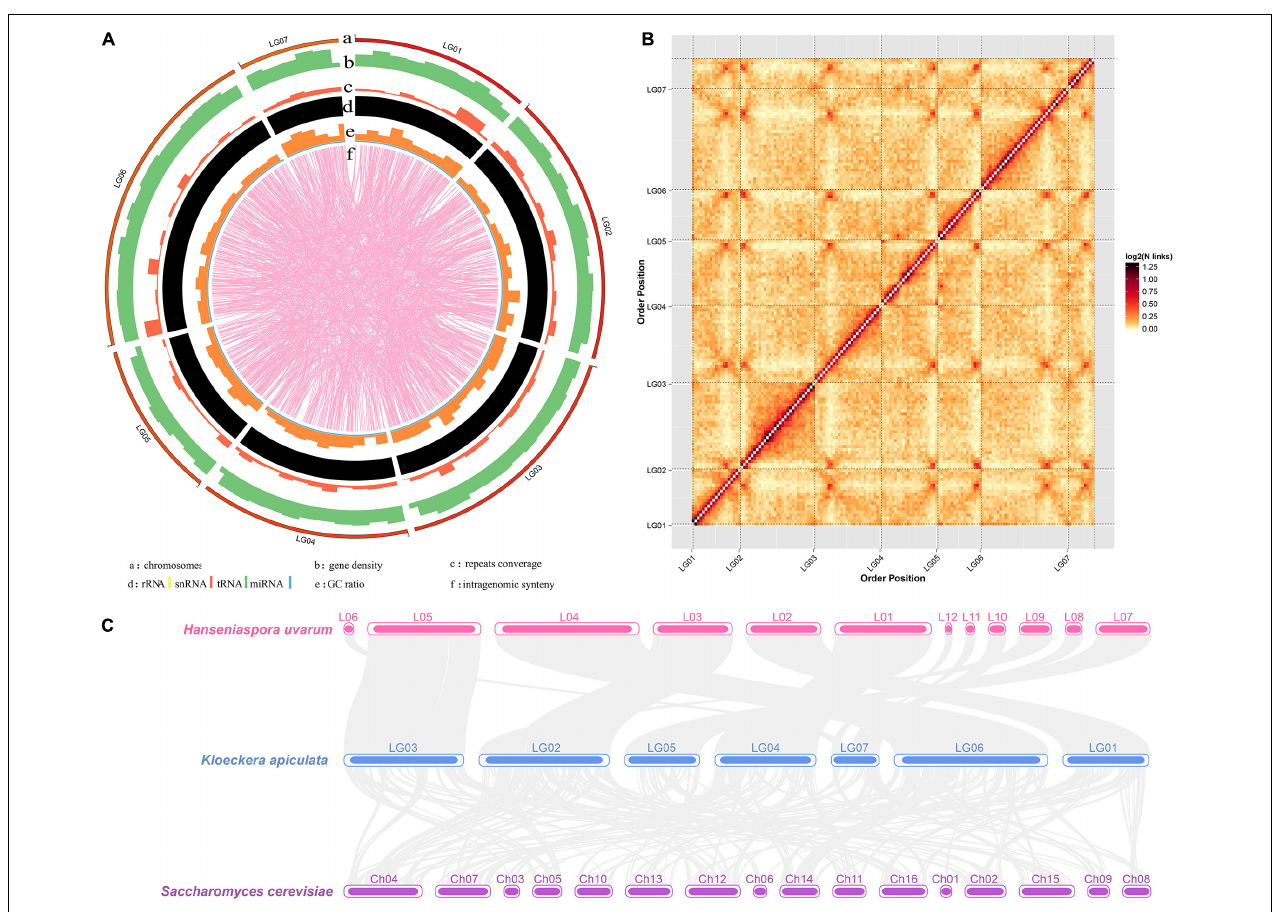
FIGURE 1 | Chromosome resolution genome of K. apiculata . Genome synteny of Hanseniaspora uvarum , K. apiculate, and Saccharomyces cerevisiae are obtained from scaffolds of H. uvarum , and chromosomes of K. apiculata 34-9 and S. cerevisiae .